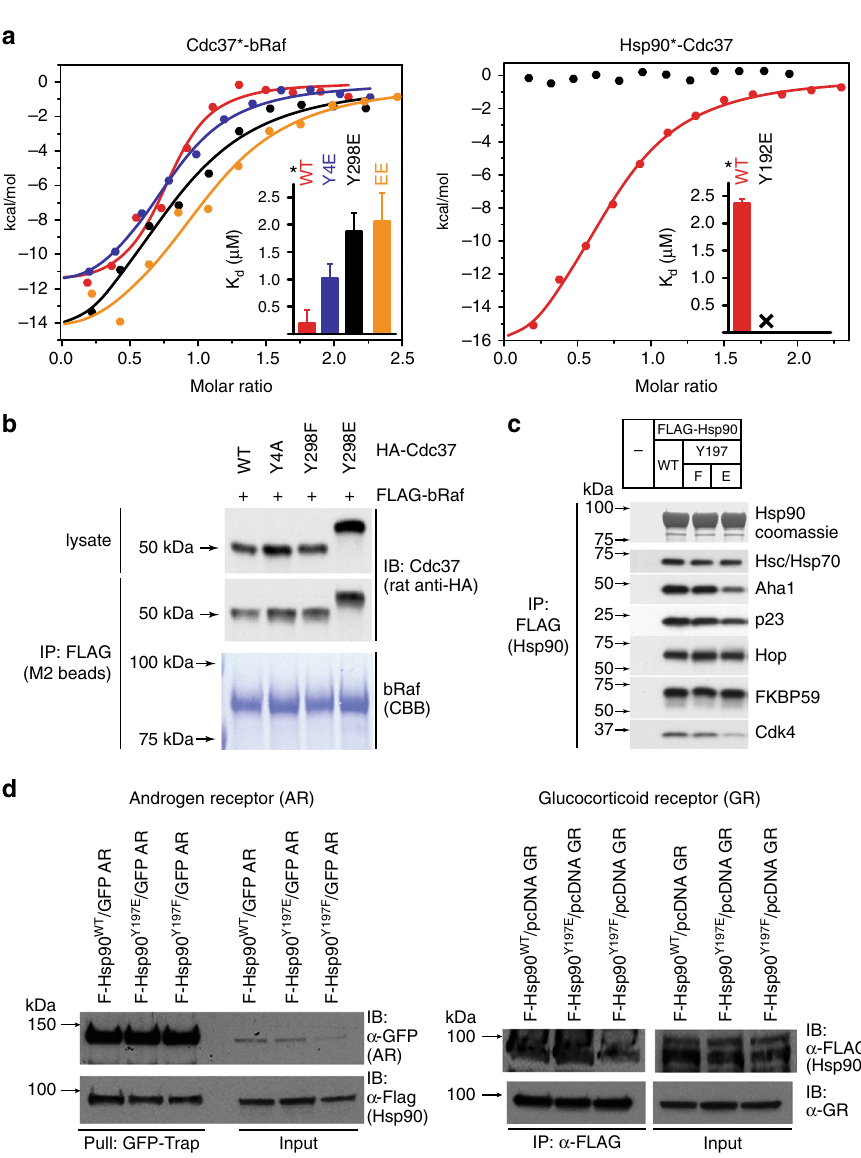
Fig. 4 Assembly of complexes of Cdc37 and Hsp90 phosphomimetic variants with clients and cochaperones. a Binary complex formation between Cdc37 variants and bRaf (left), and between Hsp90 β variants and Cdc37 (right), followed by ITC. The corresponding K d values are displayed in the inset. Error bars in the K d values correspond to the errors resulted in fi tting of the data into a single binding site model. b HEK-293 cells were cotransfected with indicated HA-tagged Cdc37 and FLAG-tagged bRaf plasmids. After cell lysis, proteins were immunoprecipitated with anti-FLAG resin for 1 h at 4 °C with rotation. Bead pellets were washed and analyzed for Cdc37 interaction by SDS-PAGE/western blot, using anti-HA antibody. c HEK-293 cells were transfected with FLAG-tagged Hsp90, Hsp90 Y197E , or Hsp90 Y197F plasmids. After cell lysis, proteins were immunoprecipitated with anti-FLAG resin for 1 h at 4 °C with rotation. Bead pellets were washed three times before analysis by SDS-PAGE/western blot. Co-precipitating endogenous Hsp70, Aha1, p23, Hop, Fkbp59, and Cdk4 were detected with speci fi c antibodies. d HEK-293 cells were transfected with the indicated Hsp90, androgen receptor (AR), and glucocorticoid receptor (GR) plasmids. Proteins were precipitated with GFP-Trap resin (left) or ANTI-FLAG M2 agarose (right) for 1 h at 4 °C with rotation. Bead pellets were washed three times with lysis buffer before analysis by SDS-PAGE/western blot as indicated. AR was visualized with anti-GFP antibody, GR was visualized with a speci fi c antibody, and Hsp90 was visualized with anti-FLAG